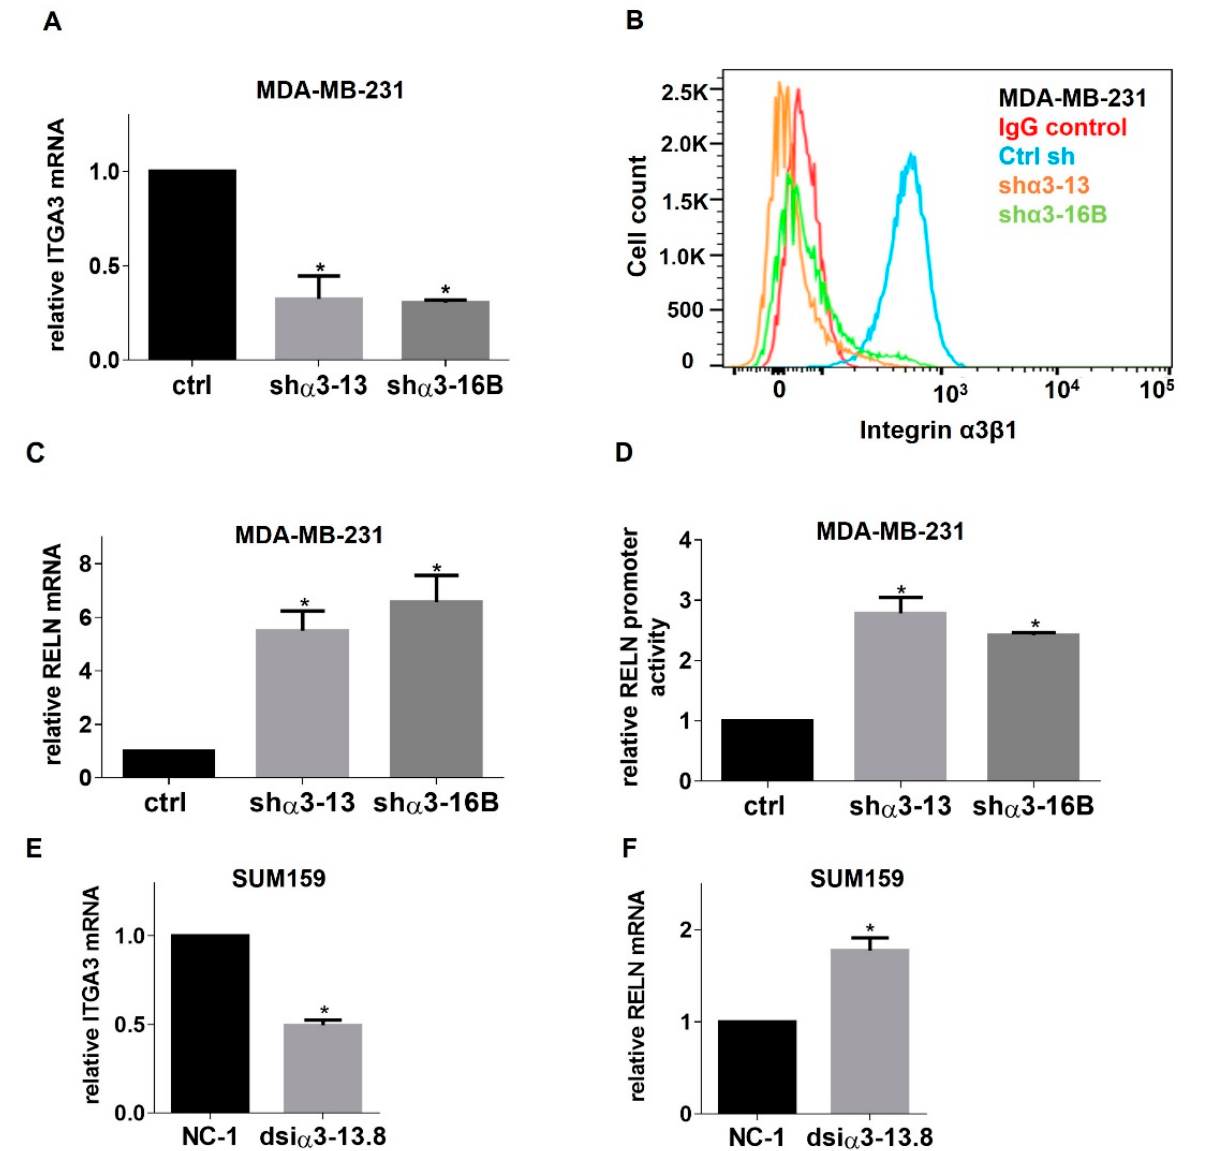
Figure 1. Suppression of integrin α 3 β 1 with shRNA or dicer-substrate siRNA significantly increases RELN mRNA expression in breast cancer cells. ( A ) qRT-PCR was performed to compare ITGA3 mRNA in MDA-MB-231 cells transduced with control shRNA (ctrl) or two distinct α 3-targeting shRNAs (sh α 3-13, sh α 3-16B). ( B ) Flow cytometry was performed with the anti- α 3 β 1 monoclonal antibody, P1B5, to compare cell surface expression of α 3 β 1 in the cells from ( A ). Control MDA-MB-231 cells were stained with normal mouse IgG as a negative control. ( C ) qRT-PCR was performed to compare RELN mRNA in MDA-MB-231 cells transduced with control or α 3-targeting shRNA. ( D ) A dual luciferase reporter assay was performed to compare RELN promoter activity in MDA-MB-231 cells transduced with control or α 3-targeting shRNA. ( E , F ) qRT-PCR was performed to compare ITGA3 mRNA ( E ) or RELN mRNA ( F ) in SUM159 cells transfected with control dicer-substrate siRNA (NC-1) or α 3-targeting dicer siRNA (dsi α 3-13.8). Data are average +/ − SEM, n = 3; * p ≤ 0.05. Multiple t -test comparison with Sidak–Bonferroni correction ( A , C , D ); unpaired t -test ( E , F